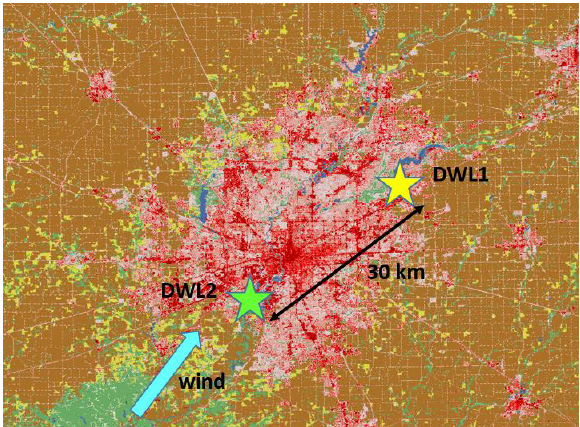
Figure 1: Land usage map from the 2011 National Land Cover Database [4] showing locations of the two Doppler wind lidars in Indianapolis, IN. Cyan arrow shows the predominant wind direction. Major land uses are developed areas (red, darker indicating denser development), and cultivated crops (light